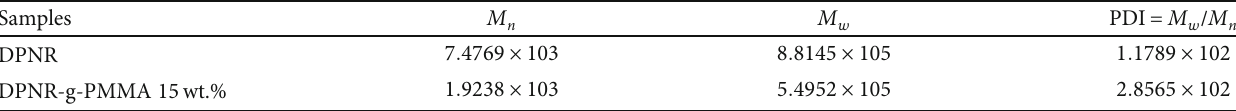
Figure 5: Molecular weight distribution for DPNR and DPNR-graft-PMMA 15 wt.%. Table 2: M , M , and PDI for DPNR and DPNR-graft-PMMA 15 n w